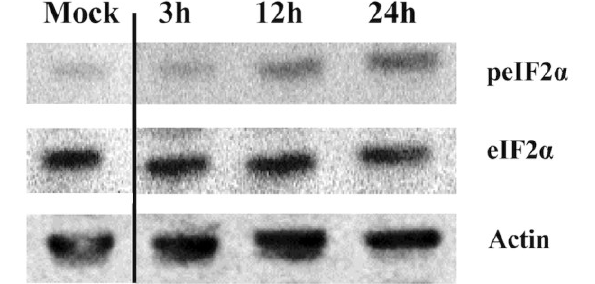
Figure 4. eIF2α phosphorylation in IPNV-infected CHSE-214 cells. CHSE-214 cells were infected with IPNV, cells were lysed at the indicated time points, and lysates were subjected to Western blot analysis using rabbit polyclonal antibodies against the phosphorylated form of eIF2α (Invitrogen). The blot is representative of a minimum of three independent observations. The numbers represent time in hours post